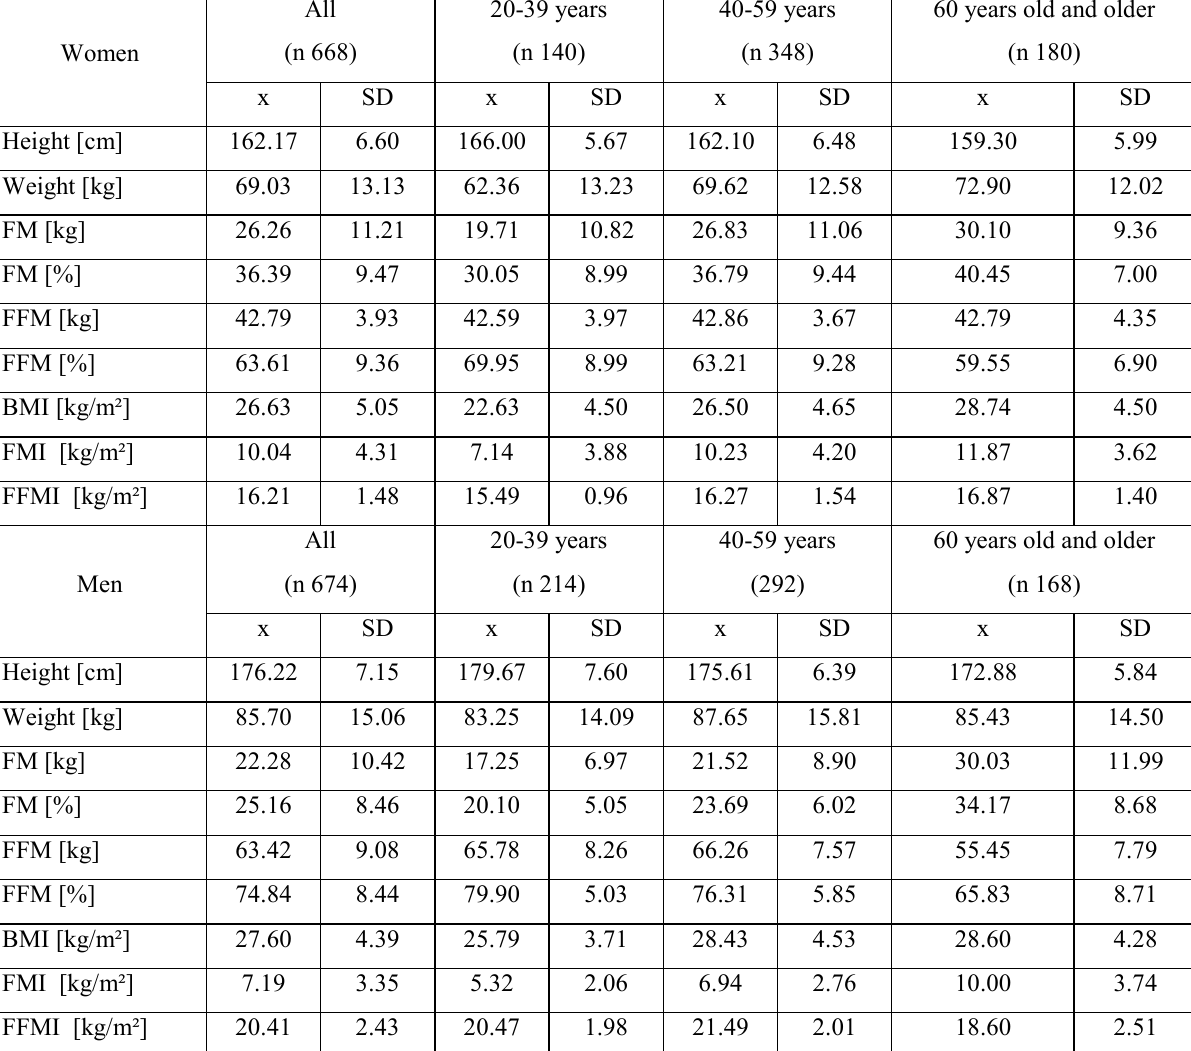
Anthropometric and body composition characteristic by gender and age